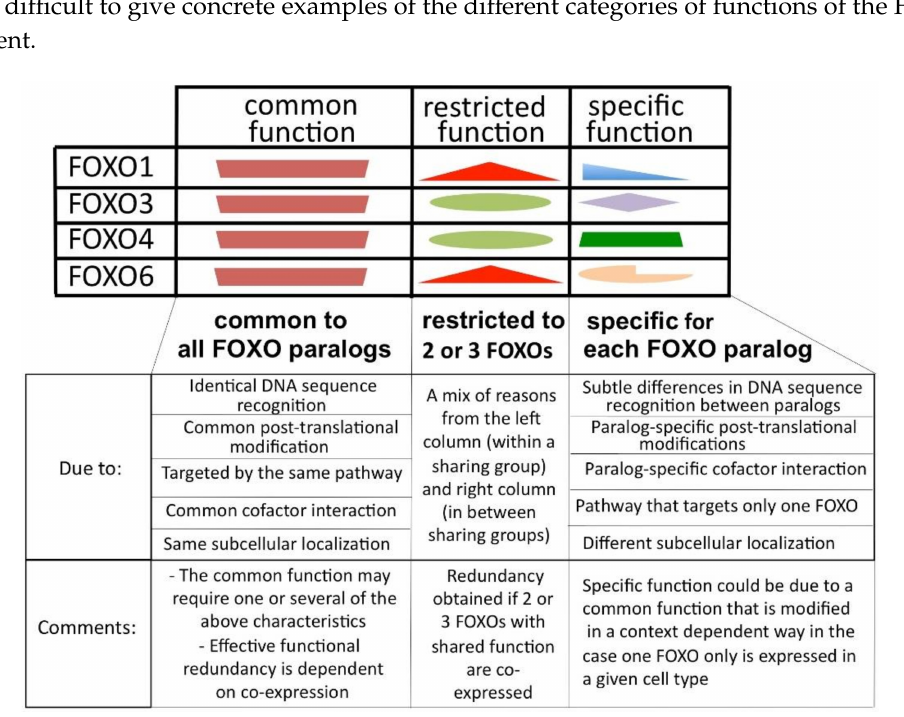
Figure 3. Possible family-related functional characteristics that could coexist in each of the paralog proteins. The space and location dedicated to the di ff erent functions in the table are not proportional to their importance or related to their location in the